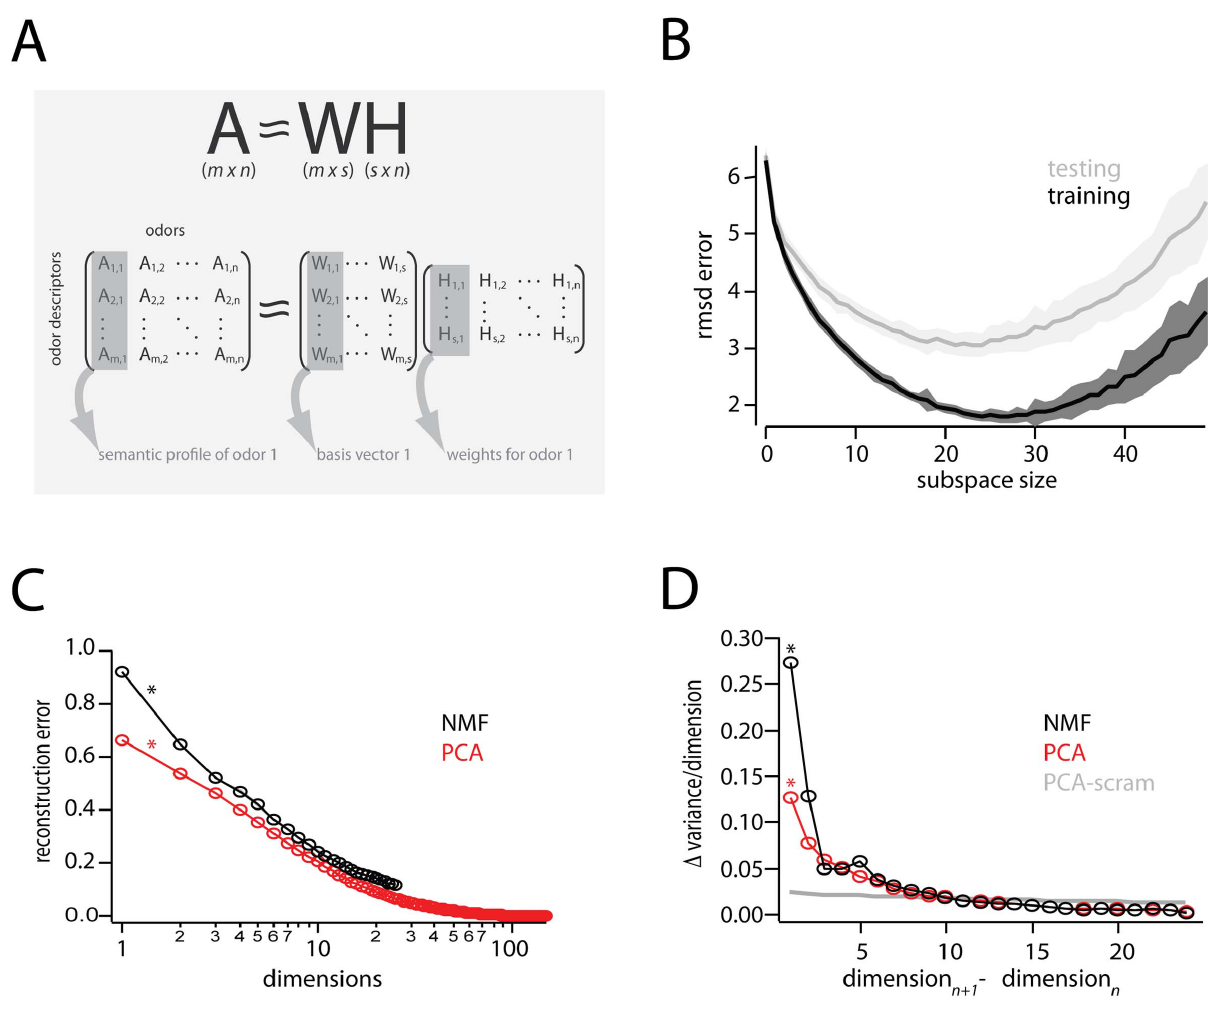
Figure 1. Summary of non-negative matrix factorization (NMF) applied to odor profiling data. A ð Þ Schematic Overview: NMF seeks a lower, s -dimensional approximation of a matrix A as the product of matrices W and H . A is m | n , consisting in the present study of 146 odor descriptors | 144 odors. A given column of A is the semantic profile of one odor, with each entry providing the percent-used value (see methods) of a given descriptor. Columns of W are basis vectors of the reduced, s-dimensional odor descriptor space. Columns of H are s -dimensional representations (weights) of the odors in the new basis. B ð Þ Plot of residual error between perceptual data, A , and different NMF-derived approximations. WH . For each choice of subspace, data were divided into random training and testing halves, and residual error between A and WH computed. One-hundred such divisions into training and testing were used to compute the standard errors shown (shaded areas). C ð Þ Reconstruction error (fraction of unexplained variance) for PCA and NMF vs. number of dimensions. The change in reconstruction error for the first interval is indicated by asterisks(*), and corresponds to the first point in the next panel. D ð Þ Change in reconstruction error for PCA and NMF, compared to the change in reconstruction error for PCA performed on a scrambled matrix ( PCA scram ). PCA scram is used to estimate the cutoff number of dimensions for which a given dimensionality reduction method is explaining only noise in a dataset. Note that each point, n , is actually the difference in reconstruction error between dimensions n and n z 1 (by way of illustration, points with an asterisk in this panel denote corresponding intervals in the previous panel C ).